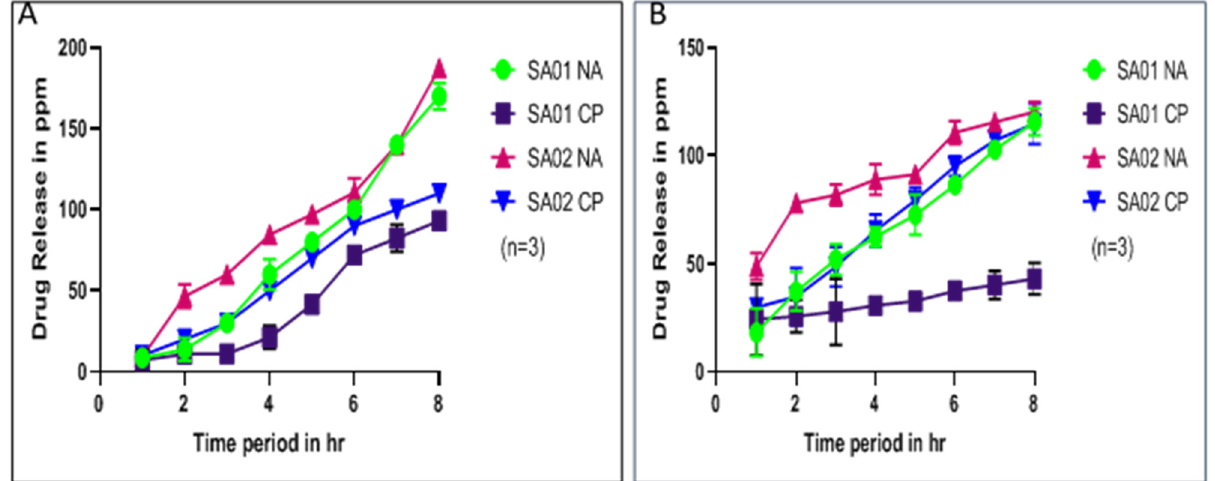
Figure 7. Drug release kinetics of SPEEK membranes SA-01 and SA-02 with two drugs in ( A ): sim- ulated body fluid (SBF) and ( B ) deionized water in both nalidixic acid sodium salt (NA) and ciprof- loxacin (CP). Lines indicate drug release concentration in ppm for 8 h.